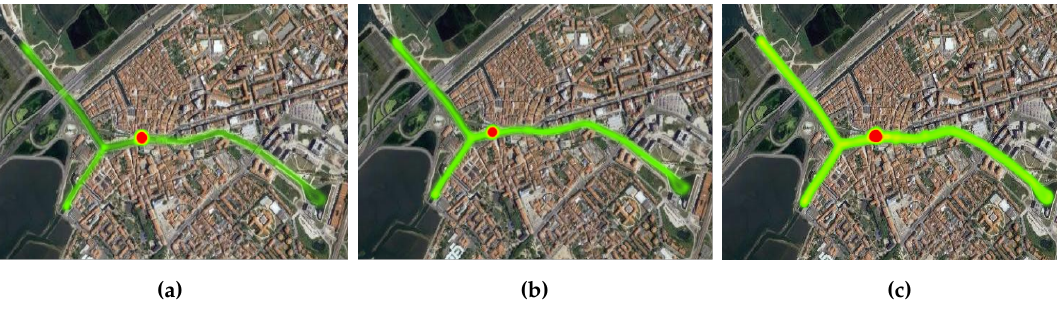
Figure 12. Moliceiros flow over day 3—Mobility-Based Controlled Replication with Neighborhood Classification strategy evaluation ( a ) Moliceiro-101 flow; ( b ) Moliceiro-102 flow; ( c ) Moliceiro-103